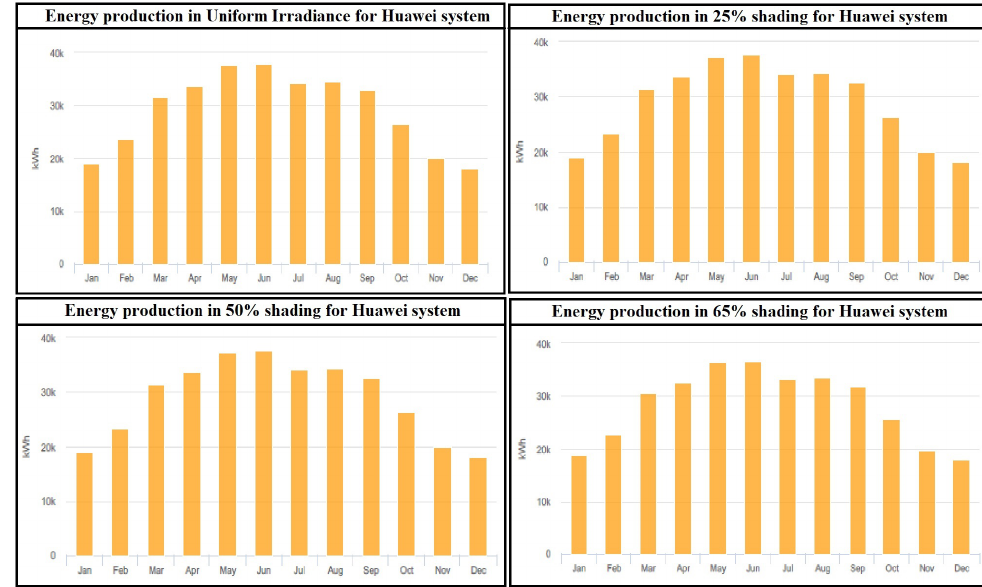
Figure 40. Results of energy production of Huawei Solar system on different shading conditions using